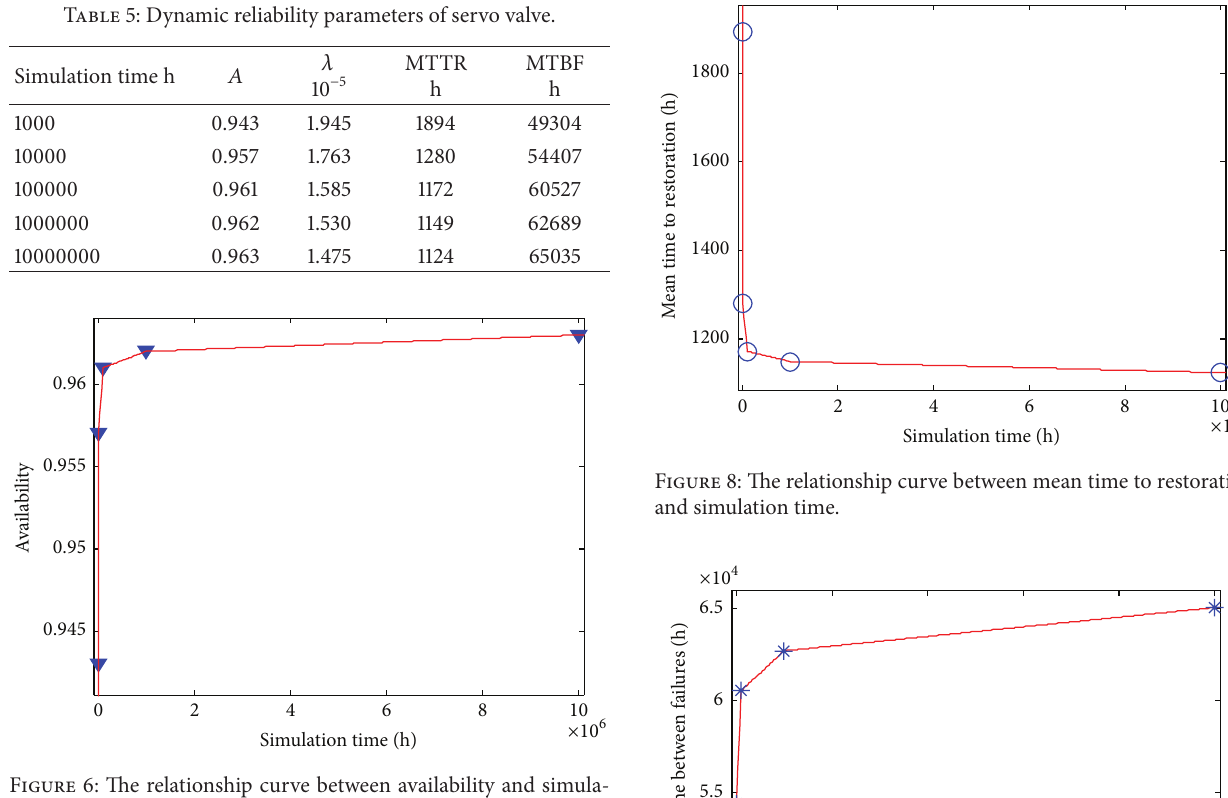
Figure 6: The relationship curve between availability and simula- tion time.